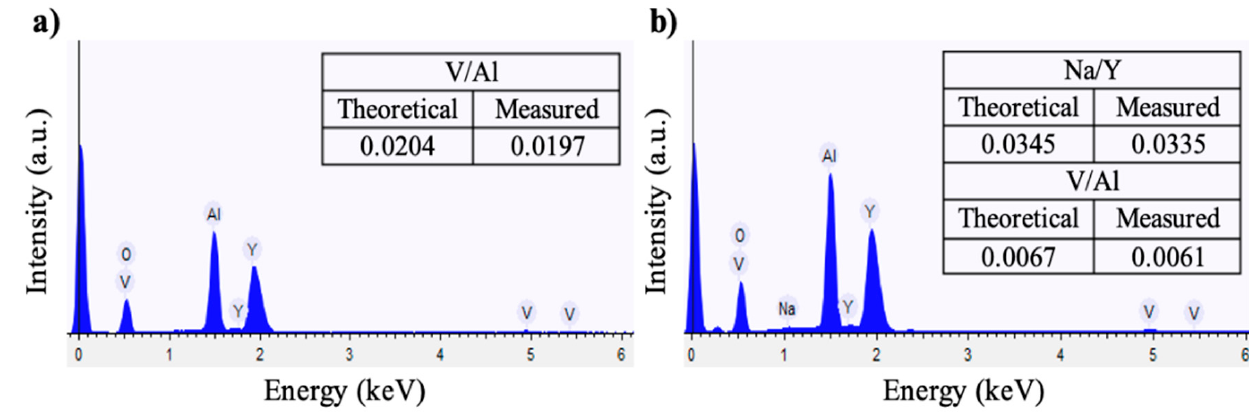
Figure 6. EDX analysis spectra of Y 3 Al 4.9 V 0.1 O 12 ( a ) and Y 2.9 Na 0.1 Al 4.9667 V 0.0333 O 12 ( b ) samples.